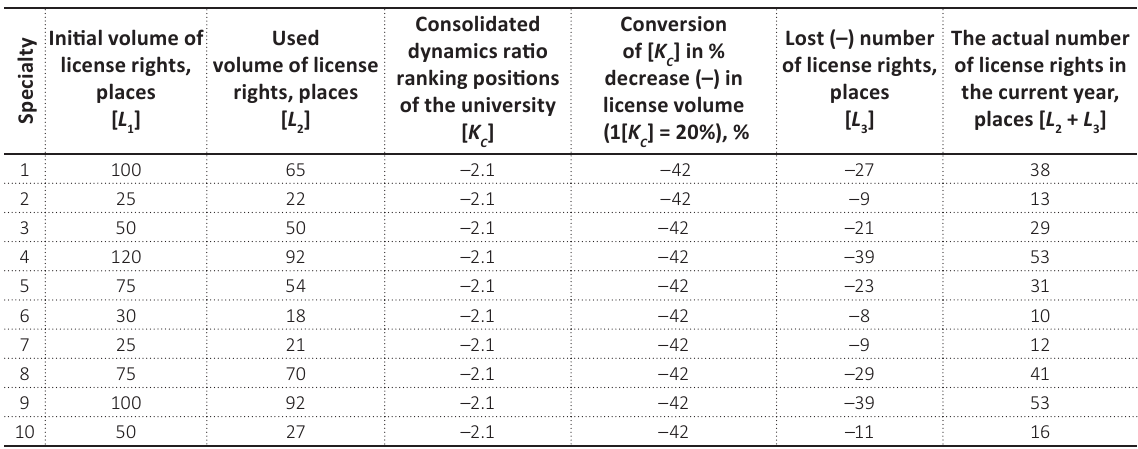
Table 4. Licensed volumes of admission to the specialties of the university No. 4 in the current year (master’s